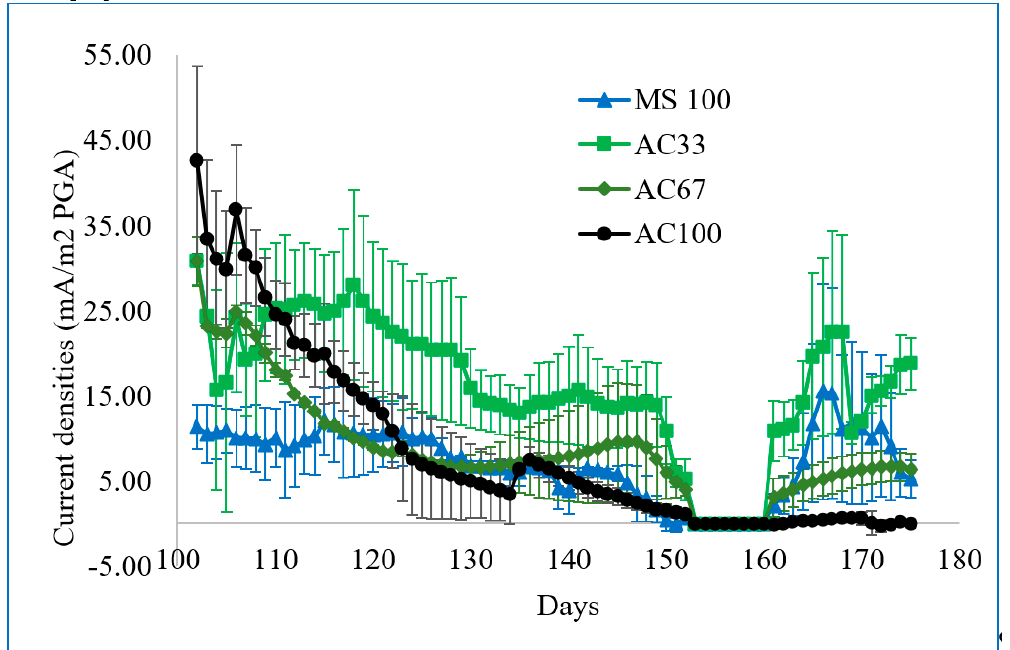
Figure 6. Average current output (mA/m 2 plant growth area (PGA)) of Plant-MFC with variation bar. The current output reached zero when anodes were dried.